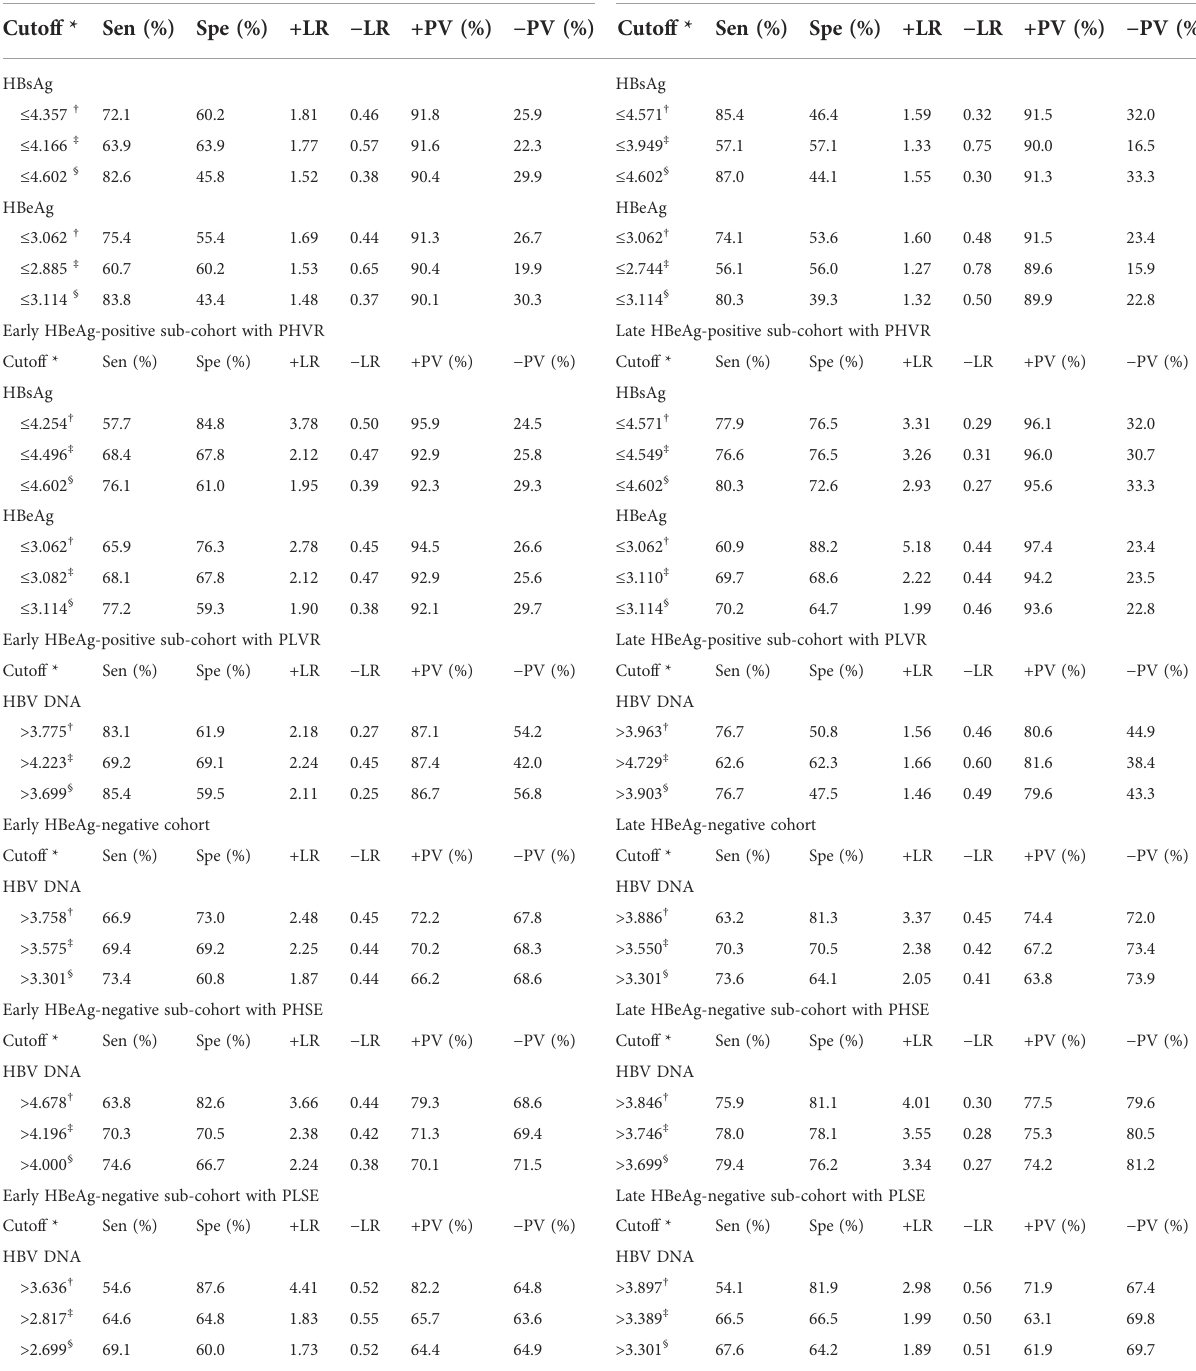
TABLE 4 Cutoffs and corresponding diagnostic parameters of HBsAg, HBeAg, and HBV DNA in predicting SHA. Early HBeAg-positive cohort Late HBeAg-positive